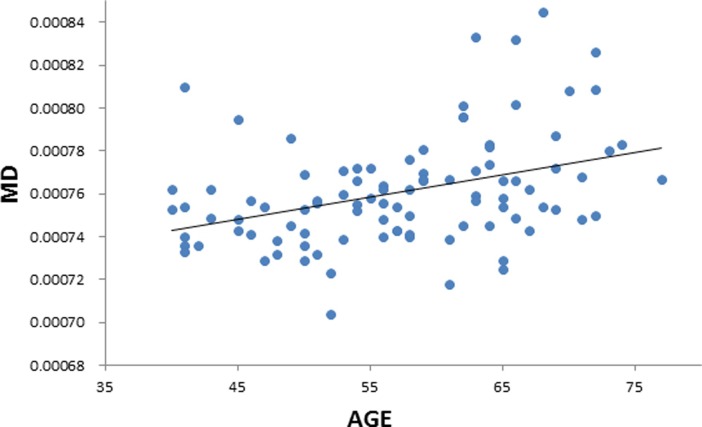
Positive correlation between age and mean diffusivity (MD).Scatterplot with regression line.